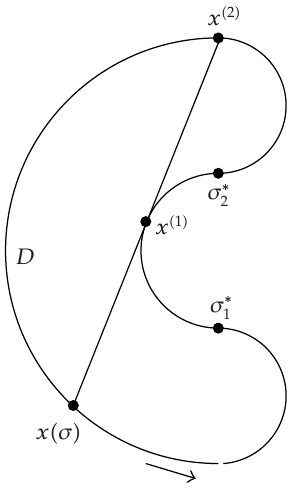
Figure 3.3. Parametric